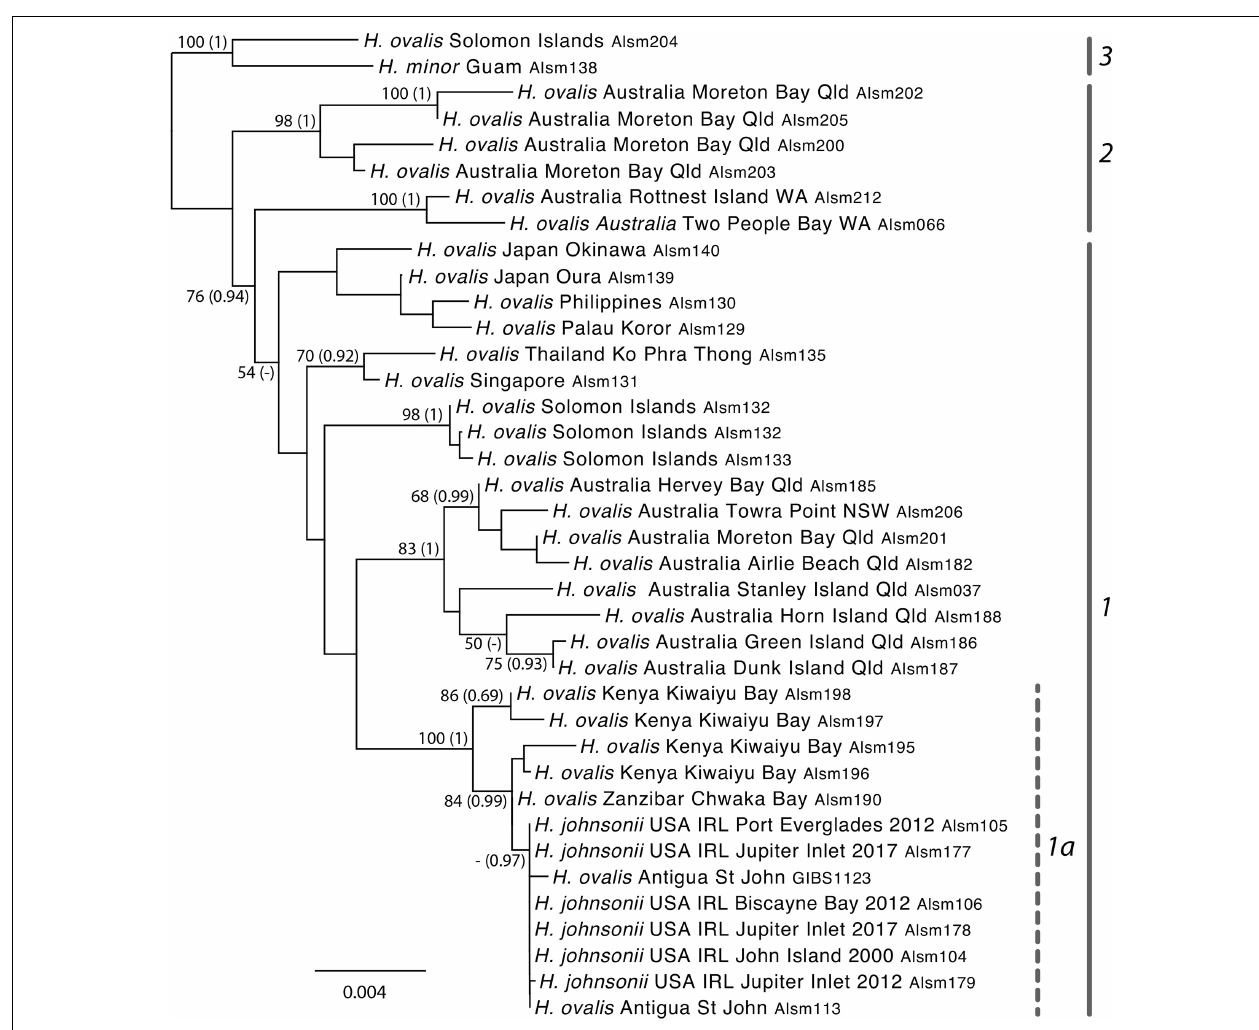
FIGURE 3 | Maximum-likelihood topology obtained from the 7 locus hybridization capture generated for nuclear (nr) gene regions across 38 samples from the seagrass genus Halophila under the GTR Gamma I substitution model using RAxML with 500 bootstrap replicates. ML support values ≥ 50%, and PP > 0.8 (Bayesian analyses, bracketed) are shown adjacent to the node. Unlabeled nodes had support values lower than this value. Highlighted groups include (as for Figure 2 ): 1 –Clade III of Uchimura et al. (2008) referred to as H. ovalis group; 1a –including H. johnsonii , along with specimens of H. ovalis from the East coast of Africa, and samples from Antigua; 2 –equivalent to clade II ( H. major group) of Uchimura et al. (2008); and 3 –specimens likely to be representative of clade IV following Uchimura et al.